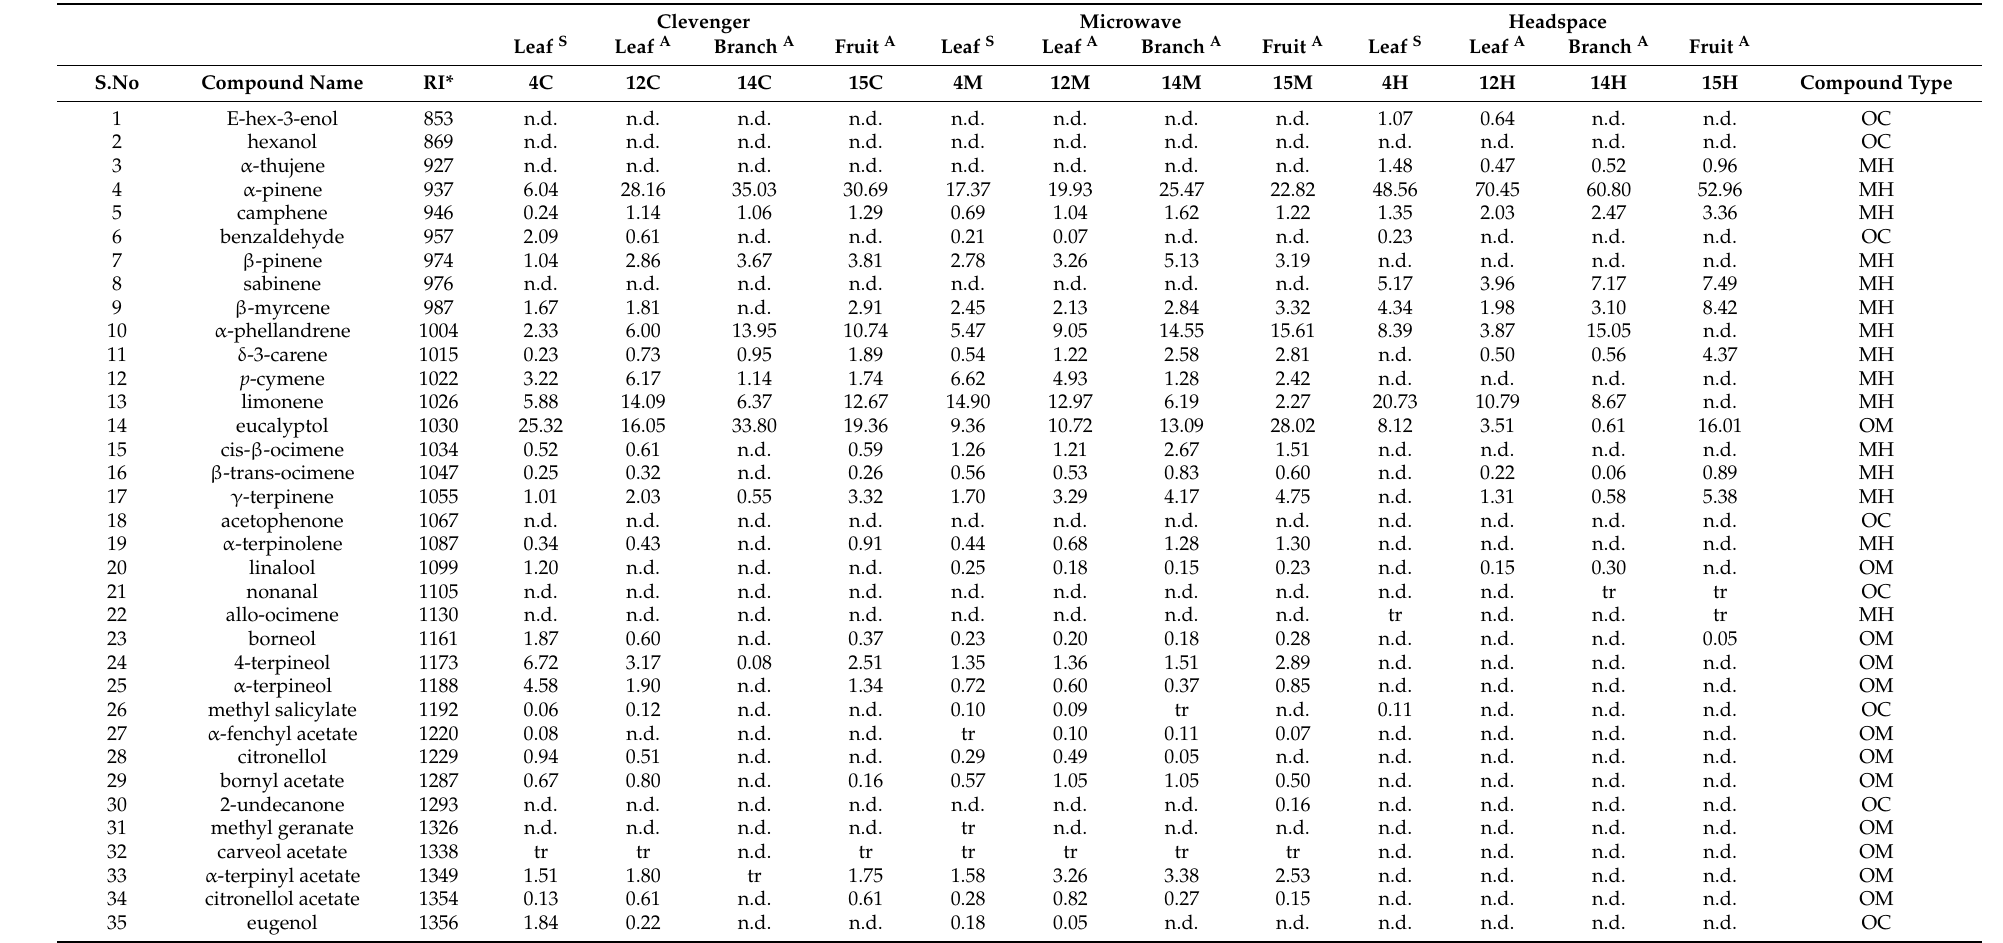
Table 2. Table showing composition profiles of essential oils extracted by Clevenger and microwave-assisted hydrodistillation and volatiles through headspace from M. gale ; values denote averaged peak area % calculated from duplicates; RI*—retention indices calculated experimentally based on retention time of n-alkane standard mix (C8–C20); n.d.—not detected; tr—trace (<0.05%); A and S in superscript denote autumn and summer collection seasons, respectively; OC—other compounds, MH—monoterpene hydrocarbon, OM—oxygenated monoterpene, SH—sesquiterpene hydrocarbon and OS—oxygenated sesquiterpene.